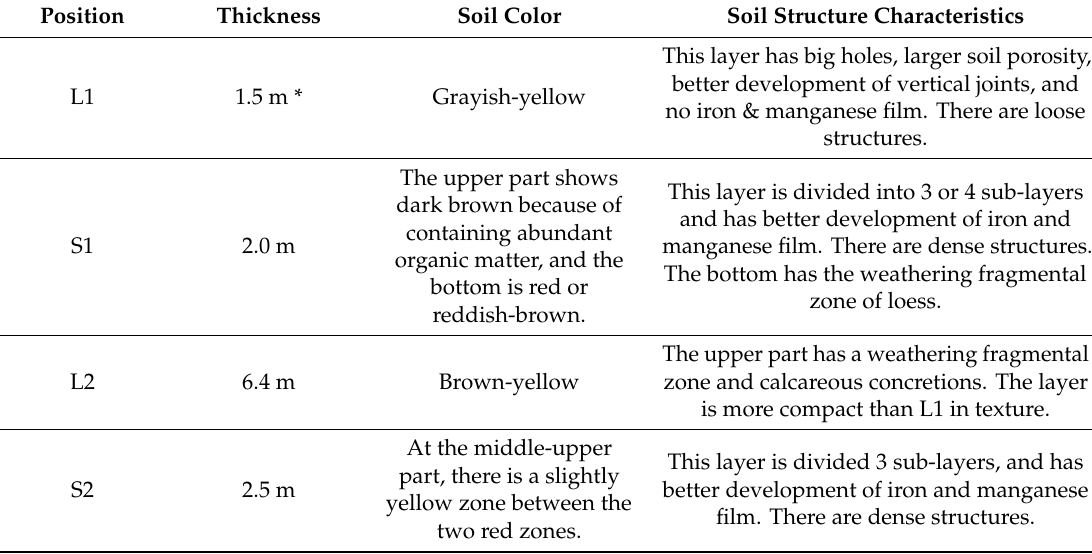
Table 1. Soil thickness of L1-S5 at the Bailu tableland